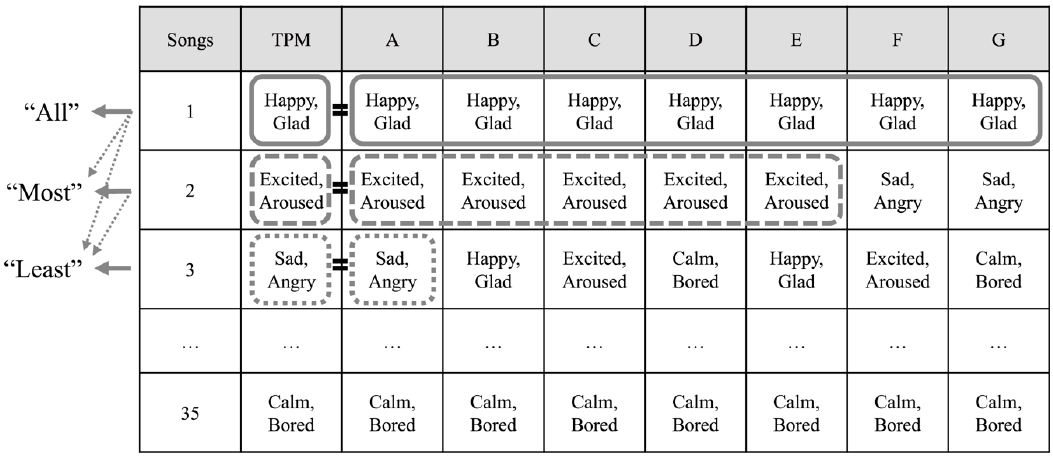
Figure 11. Comparison